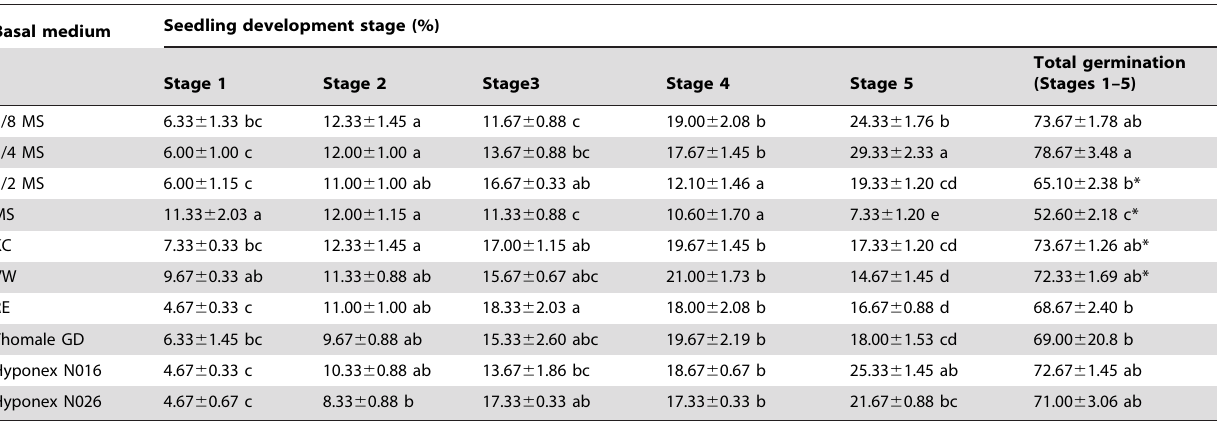
Table 2. Effect of basal medium supplemented with 0.5 mg l 2 1 NAA, 10 g l 2 1 sucrose and 1.0 g l 2 1 AC on germination and development of Renanthera imschootiana 150 DAP seed after 75 days in